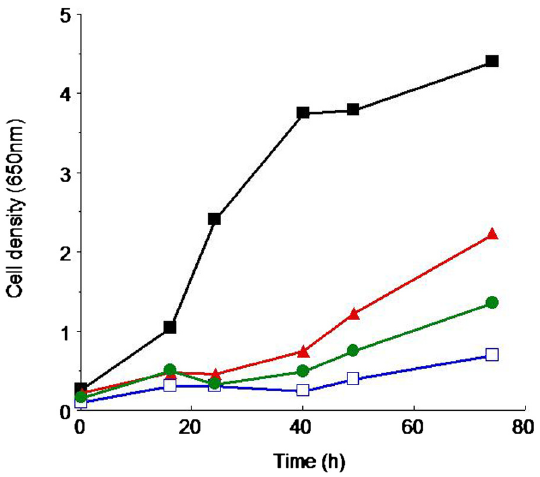
Figure 2 . Growth of acid phosphatase-negative yeast strain in liquid uracil-de fi cient medium containing ATP. Yeast carrying pVT101-CD39 ( ■ ), pVT101-CD39CT ( ▲ ), pVT101-CD39NT ( ● ), and pVT101 ( □ ) were grown in DO-U medium, pH 7.2 at 30°C con- taining 0.3 mM ATP.